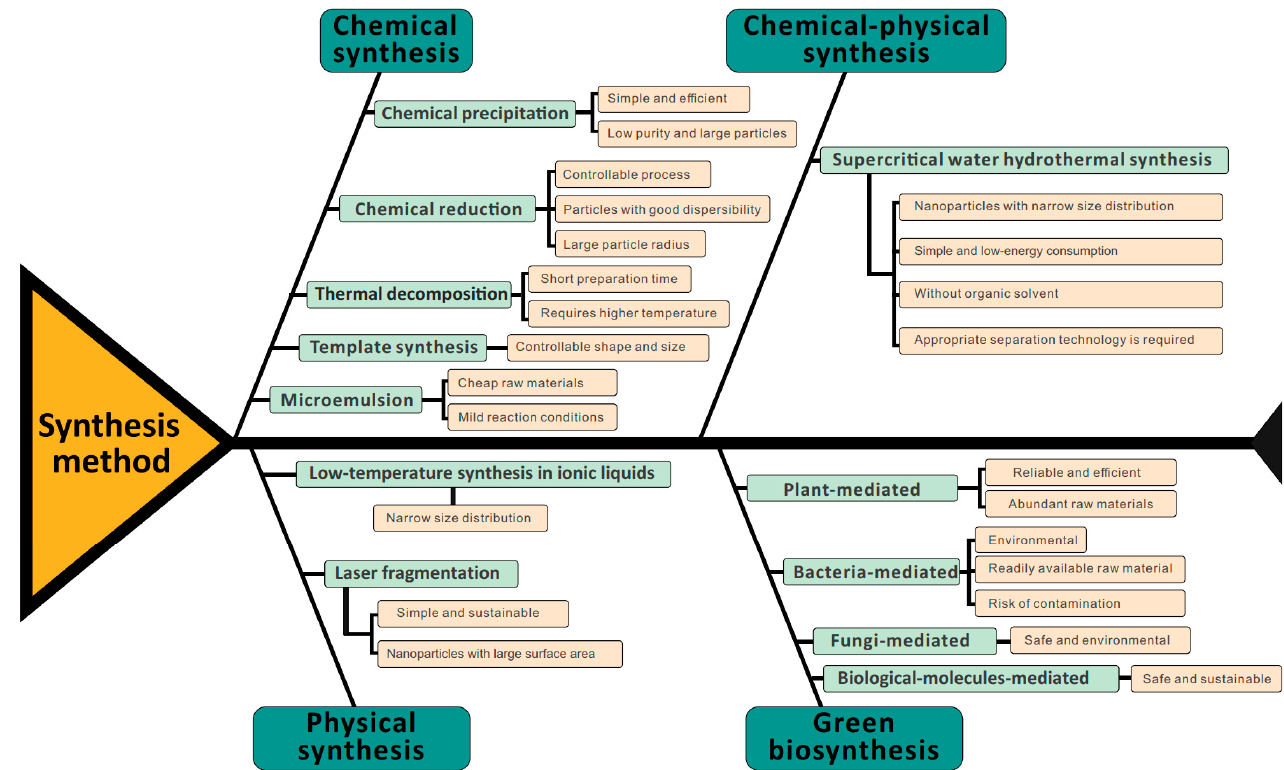
Figure 1. Typical synthesis method for cobalt oxide nanoparticles.